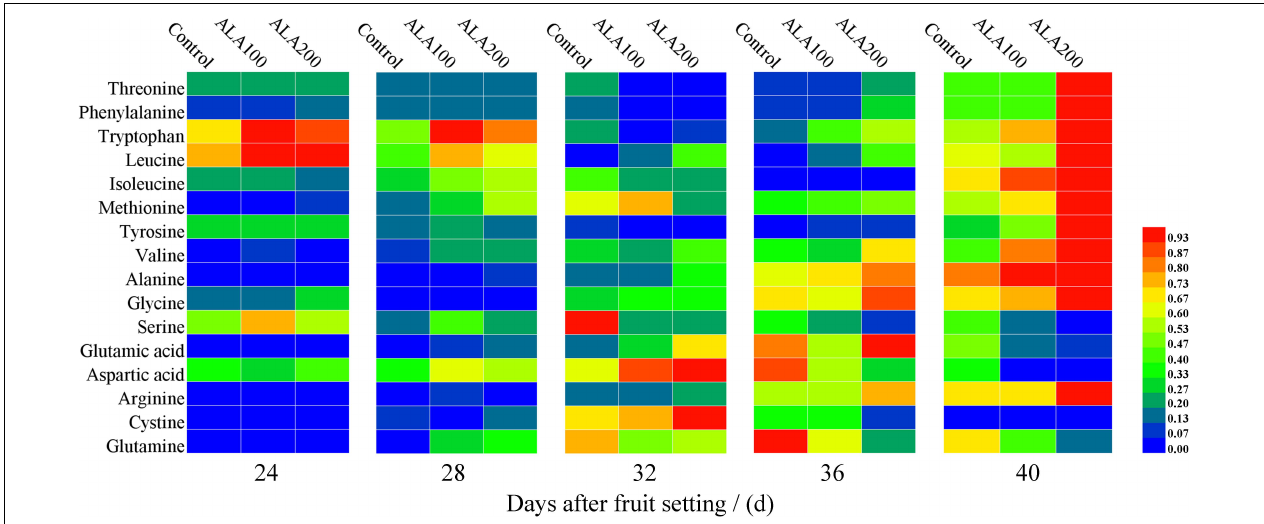
FIGURE 3 | Heat map of the effects of ALA on amino acid components in tomato fruit. Min-Max normalization method was used to standardize the data (Mohamad and Usman, 2013). The color block represents the relative value of amino acid components in the corresponding position.